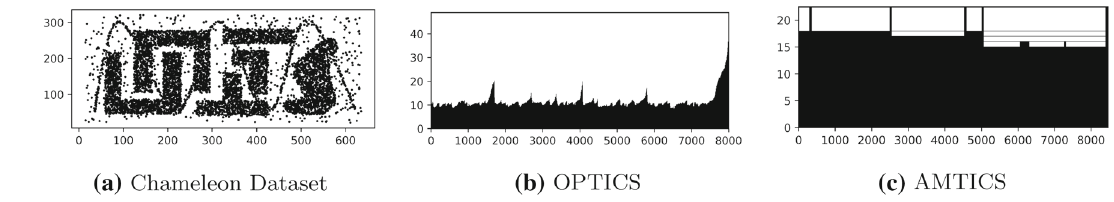
Fig. 9 OPTICS and AMTICS in comparison on the Chameleon dataset